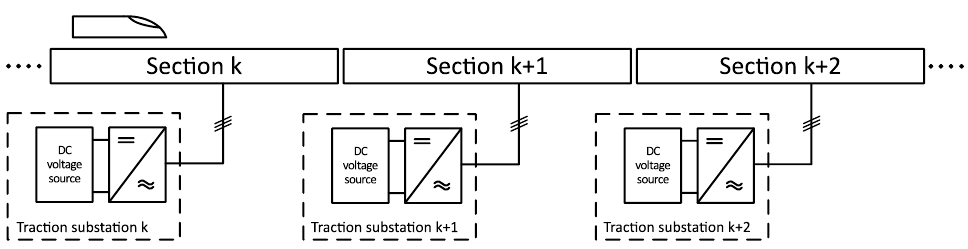
Figure 1. Block diagram of the multi-section drive system.